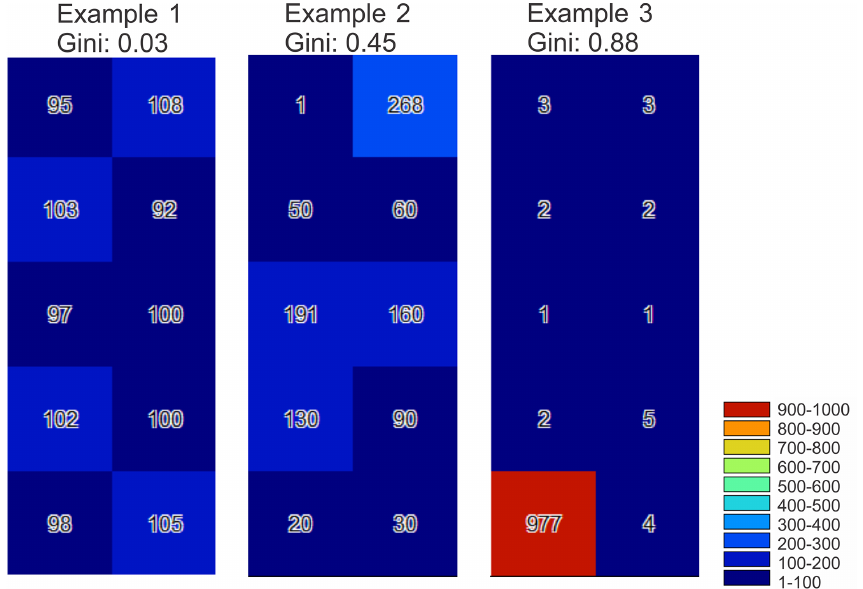
Figure 1. Gini coefficients for three examples of 10 grid cells with the same mean value (i.e., 100) as an illustration of the added value of the Gini coefficient. Example 1 has similar grid values (i.e., low Gini value), example 2 has more diverse grid values (i.e., Gini value around 0.5), and example 3 has significant inequality (i.e., Gini value close to 1). Table 1. Mean, standard deviation, and Gini coefficient of the global rainfall erosivity maps derived using CMORPH and ED. Continent CMORPH ED Mean SD Gini (–) Mean SD Gini (–) (MJmmha − 1 (MJmmha − 1 (MJmmha − 1 (MJmmha − 1